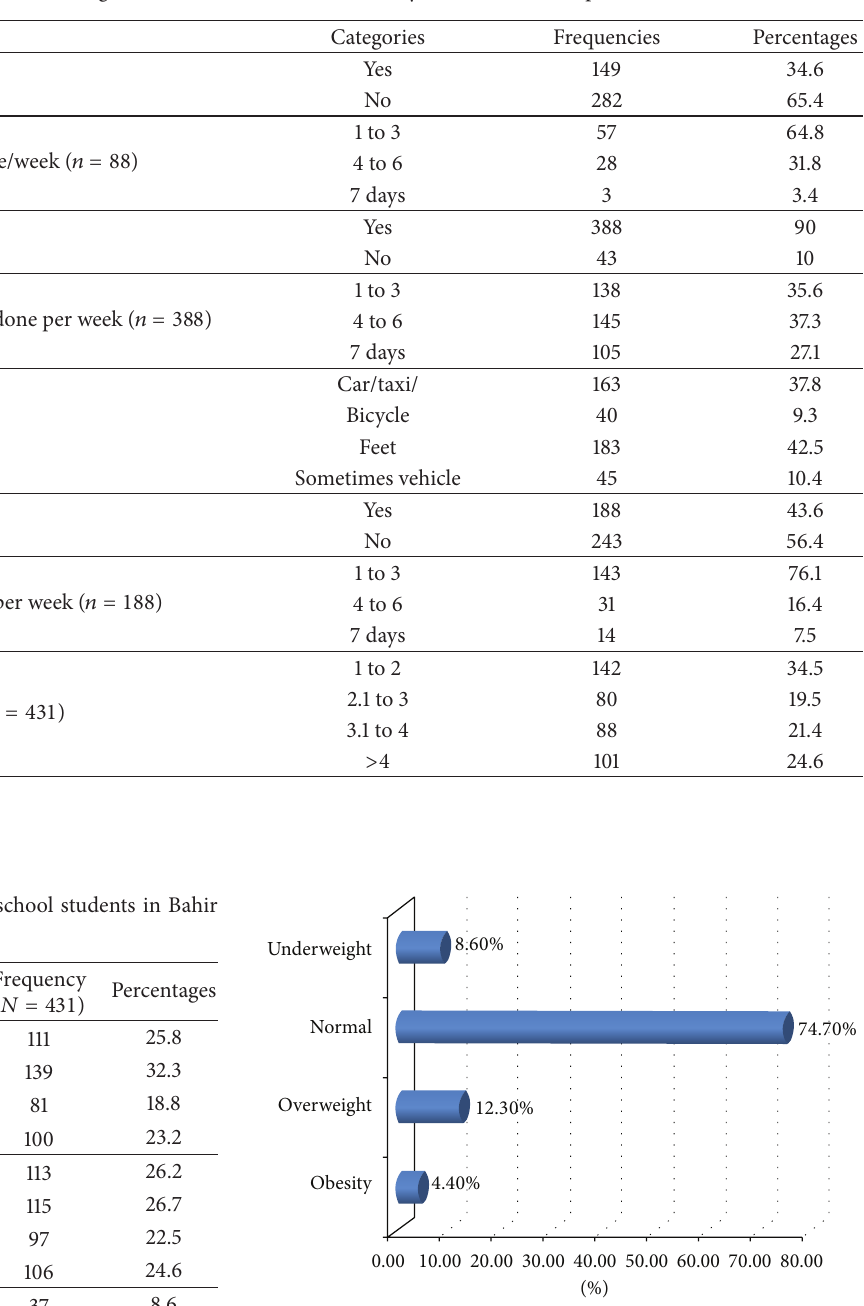
Table 3: Physical activities of high school students in Bahir Dar city, North West Ethiopia, 2014.